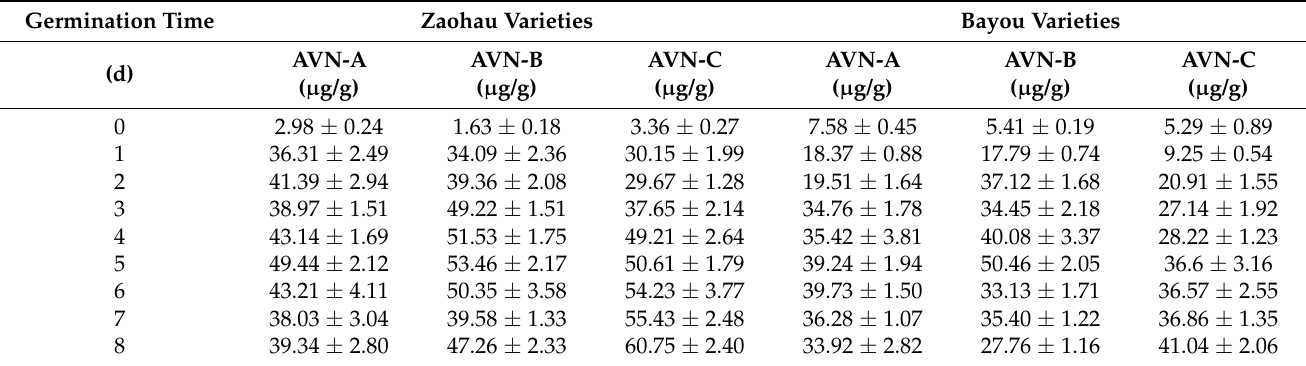
Table 5. Changes in the AVN contents of oat after